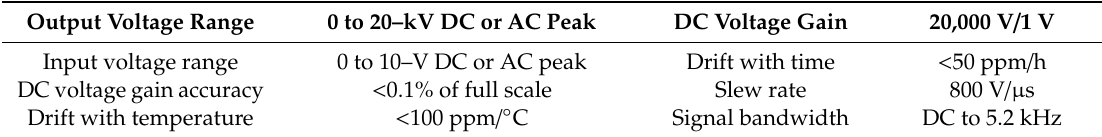
Table 1. Trek power amplifier